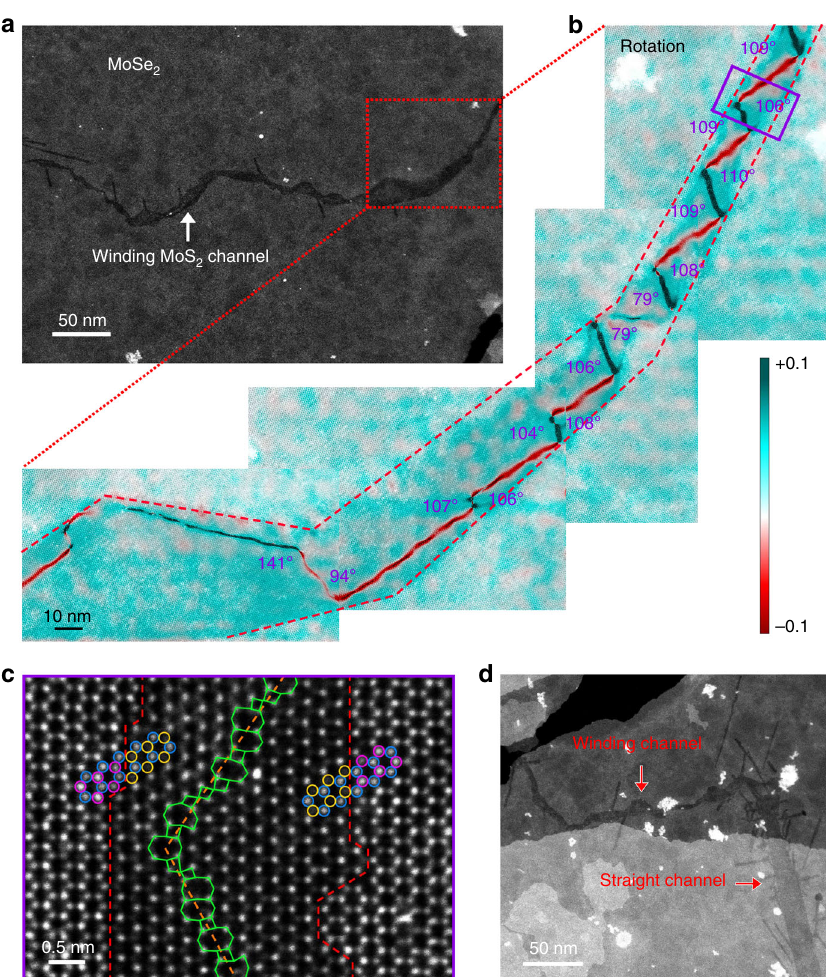
Fig. 4 Rotation map and structure analysis of winding MoS 2 channels. a Low-magni fi cation ADF-STEM image of a winding MoS 2 channels. b The superimposed image of the channel and its corresponding rotation map. c High-resolution ADF-STEM image showing the atomic structure of the rectangular area in b . The heterojunction interface is highlighted by the red dashed lines. 60°GB (orange dashed line) is formed by 4|8 rings (green tetragons and octagons). Blue, purple, and yellow circles represent Mo, Se, and S atoms. d ADF-STEM image of a winding channel connecting with a straight